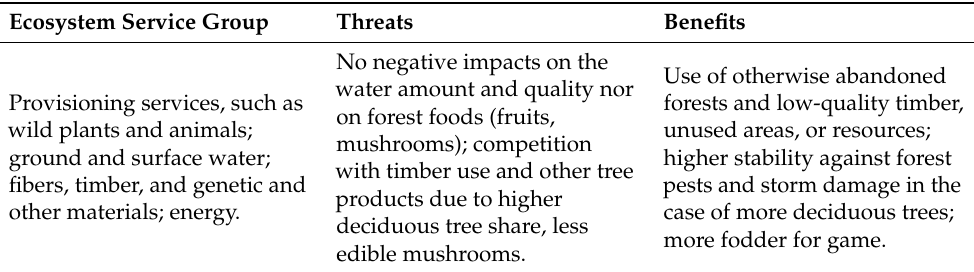
Table 2. Qualitative comparison of the foreseeable threats and benefits of higher use of bioenergy from the forest, caused by intensified use and a reinforced trend towards more deciduous trees (due to higher deciduous firewood demands and